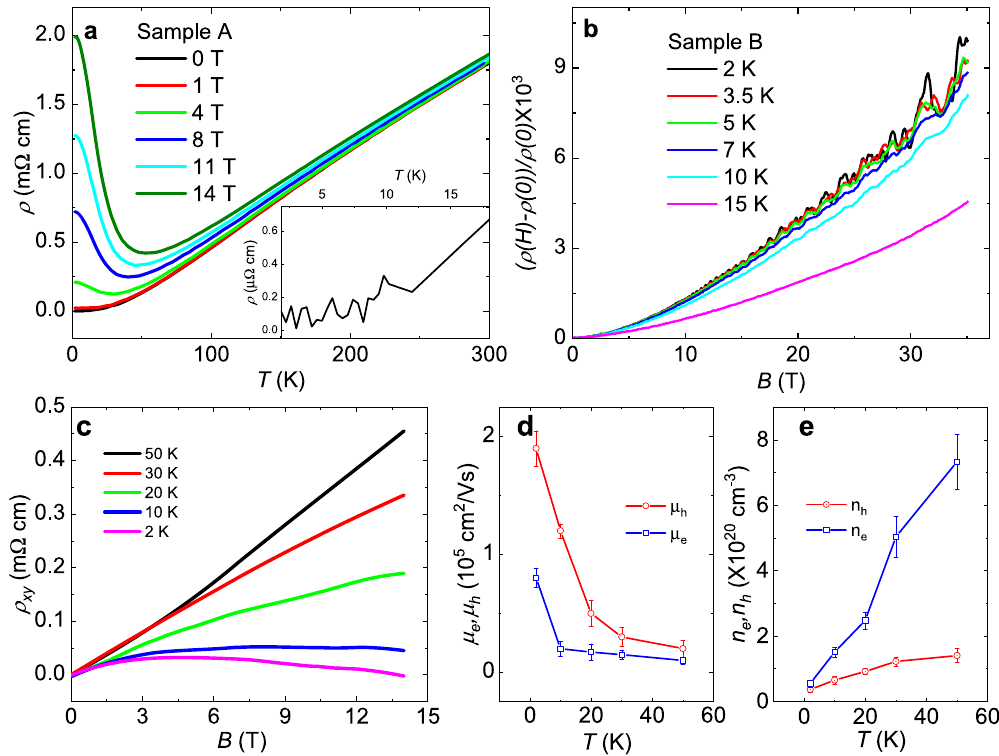
Fig. 4 Extremely large magnetoresistance and carriers of Dirac semimetal BaAl 4 . a Temperature dependence of the resistivity at different magnetic fi eld which is perpendicular to the electrical current for single crystal sample A. b Transverse magnetoresistance with current in the ab plane and fi eld along the c-axis, for single crystal Sample B at several representative temperatures under fi eld up to 35 T. In the measurements, the current is in the ab plane and the fi eld is along the c -axis. c Field dependence of the Hall resistivity measured at several representative temperatures. d , e Temperature dependence of the mobility of the holes ( μ h ) and electrons ( μ e ), as well as the density of the holes ( n h ) and the density of the electrons ( n e